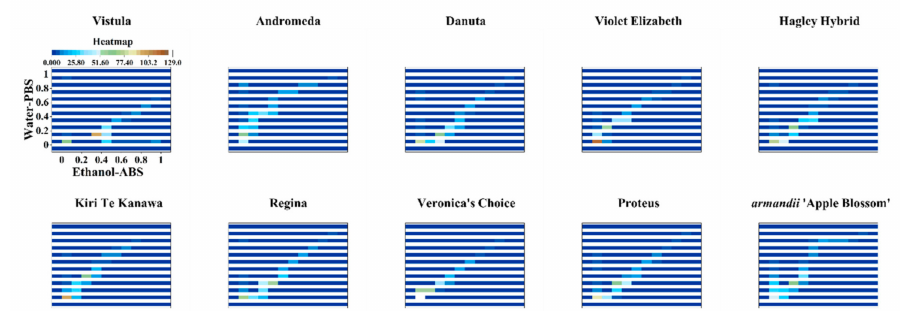
Figure 6. Hot maps of Vistula, Andromeda, Danuta, Armandii ‘Apple Blossom,’ Proteus, Hagley Hybrid, Violet Elizabeth, Kiri Te Kanawa, Regina, and Veronica’s Choice using data recorded from the 0.1 M PBS after water extraction vs. the 0.1 M ABS after ethanol